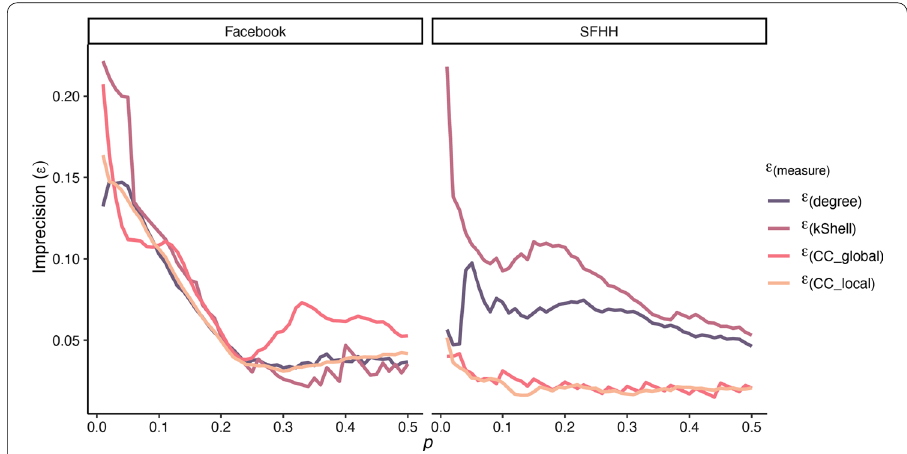
Fig. 4 Imprecision of identifying the top p fraction of spreaders by different measures over growing p with regard to the peak